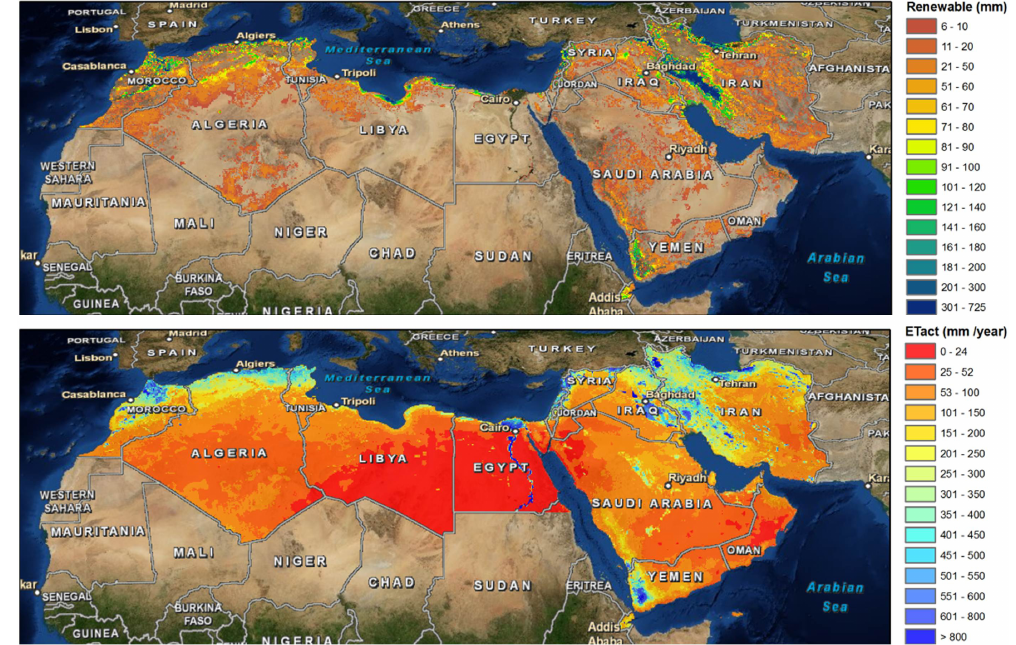
Fig. 6. Internal renewable water resources and actual evapotranspiration based on PCR-GLOBWB for the period 2000–2009.